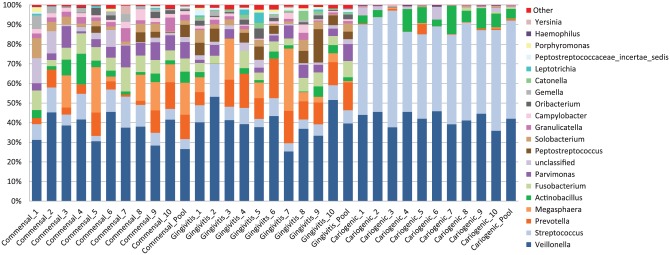
Relative abundance of major bacterial genera. Sequence data for
determining the genera are obtained from cultured commensal, cariogenic,
and gingivitis biofilms from 10 individual donors and the pooled saliva
from the 10 donors. Remaining genera are shown as “other.”